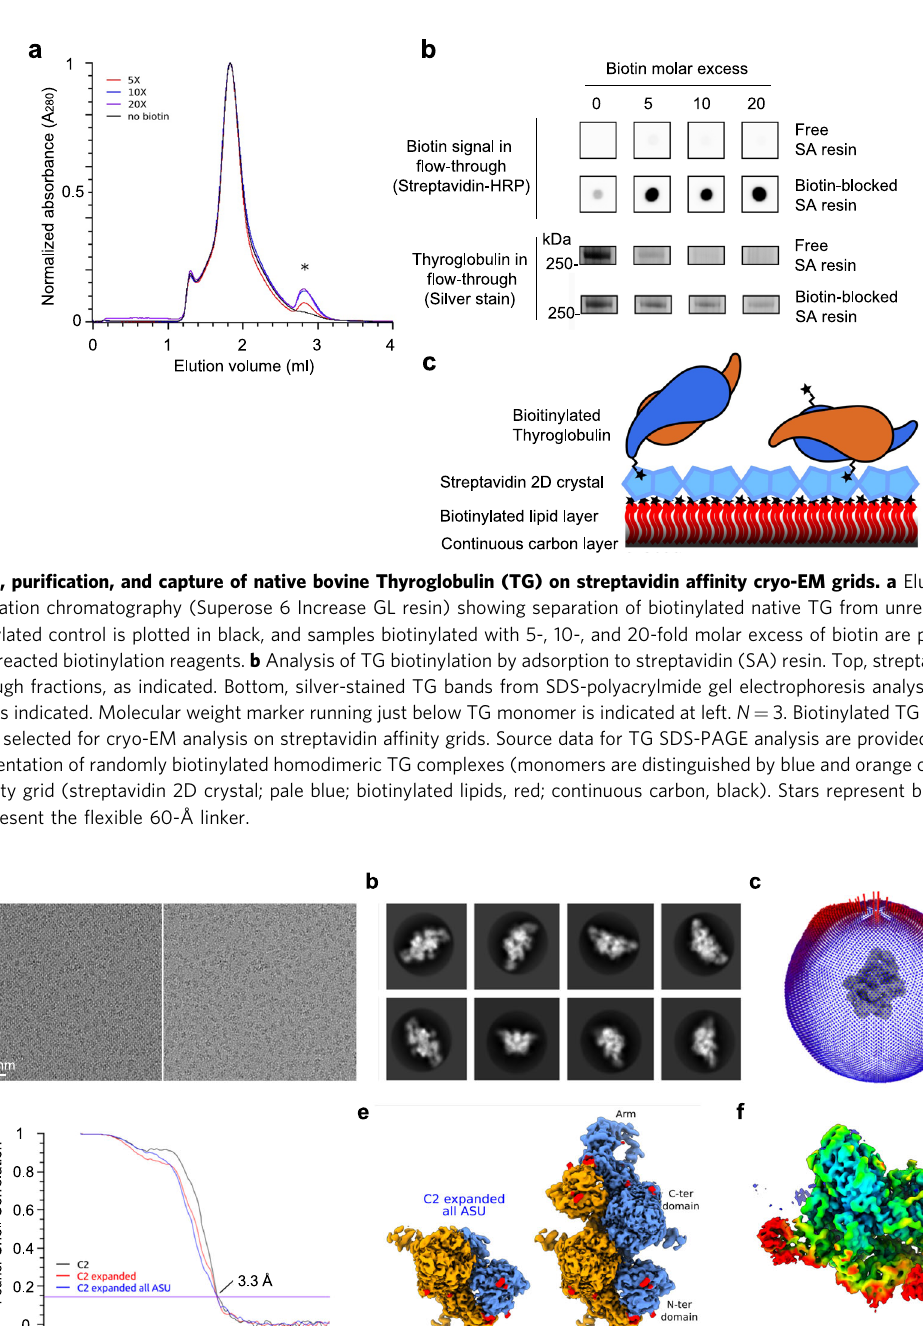
NATURE COMMUNICATIONS| (2022) 13:2380